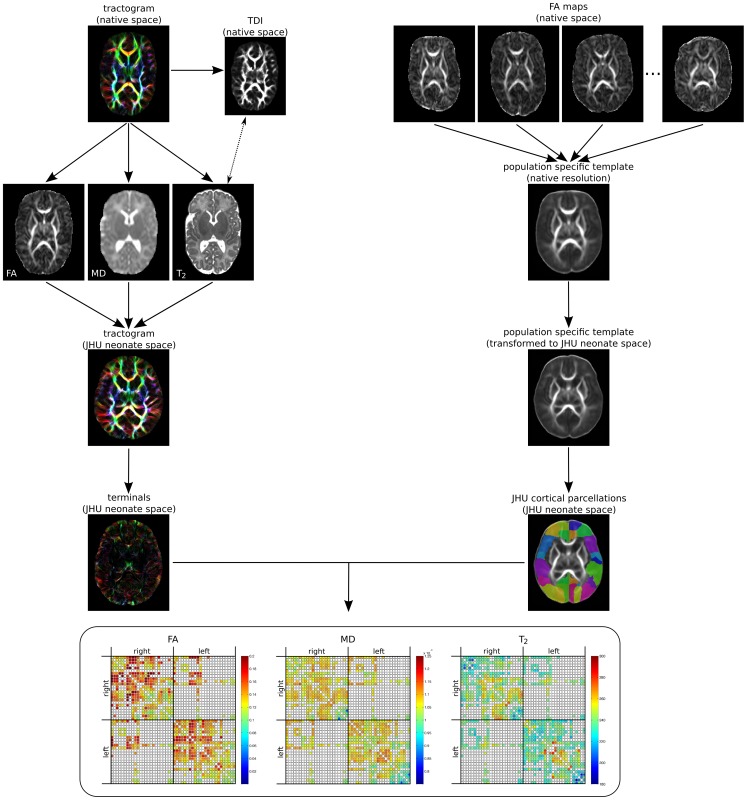
Workflow for obtaining the structural connectome.Whole brain tractograms are generated in native diffusion space. Maps of FA, MD and T2 (co-registered via the TDI) are sampled prior to transformation of the tractogram to JHU neonate space. Registration to JHU neonate space was performed by first calculating a study-specific FA template, which was then aligned with the JHU neonate FA template. Only the terminals of streamlines (10 points) are hit-tested with JHU neonate cortical target regions to assemble the connectomes.